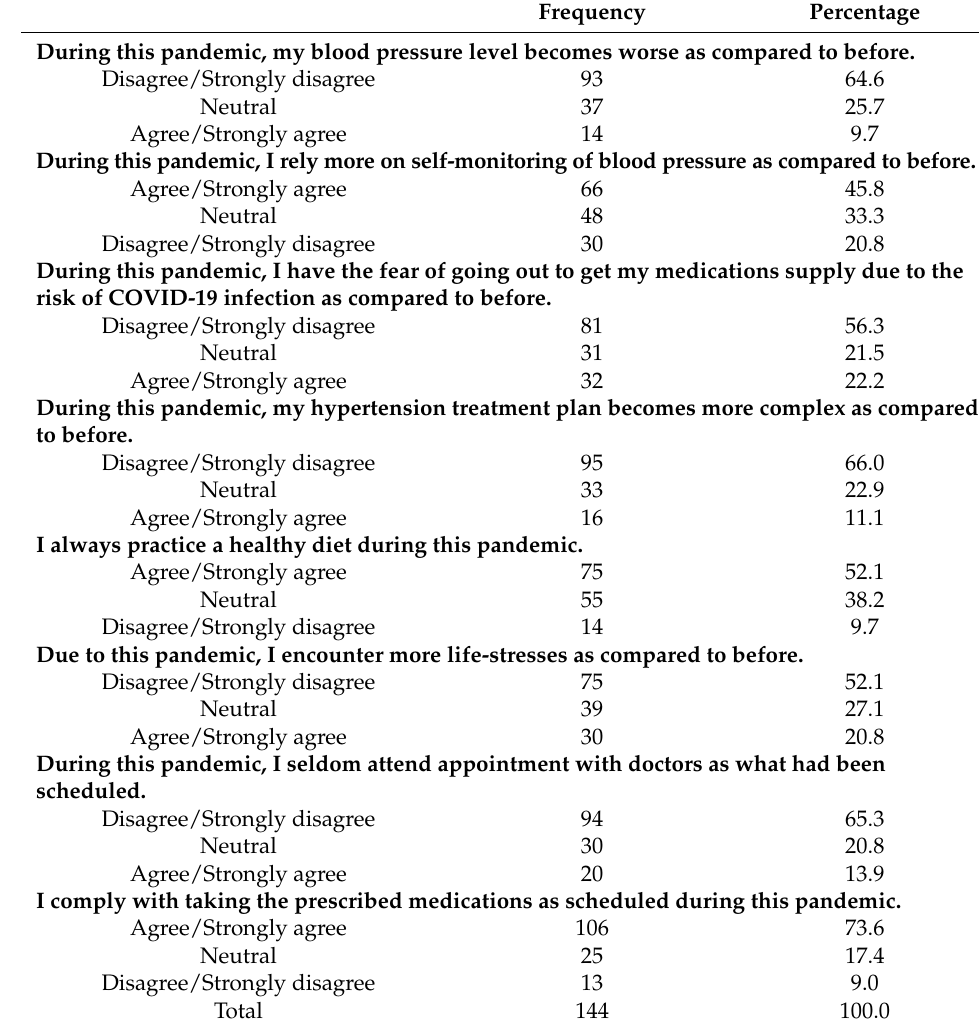
Table 4. Responses to items related to items assessing the pandemic impact on hypertension control.